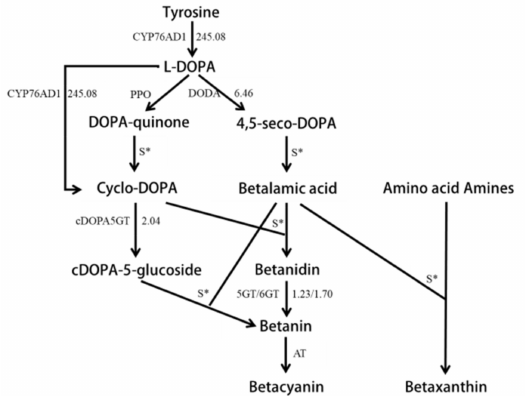
Figure 4. The differential expression of structural genes in the tyrosine pathway. Arrows show the metabolic stream, left or upward arrows represent the genes catalyzing the progress, and the number represents the up-regulation times of the genes in red pitayas compared to white